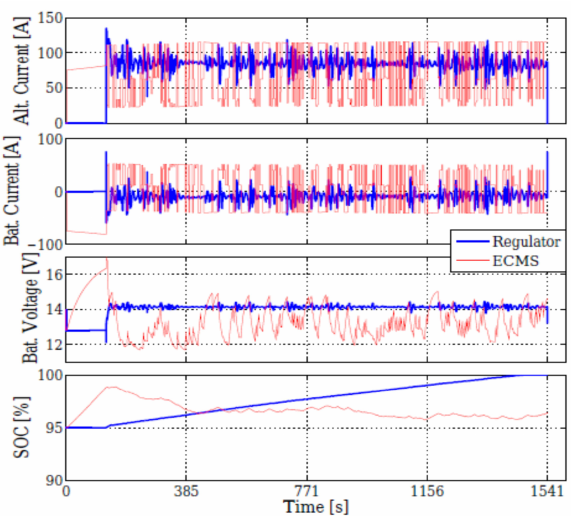
Figure 11. Simulation results for the proposed algorithm